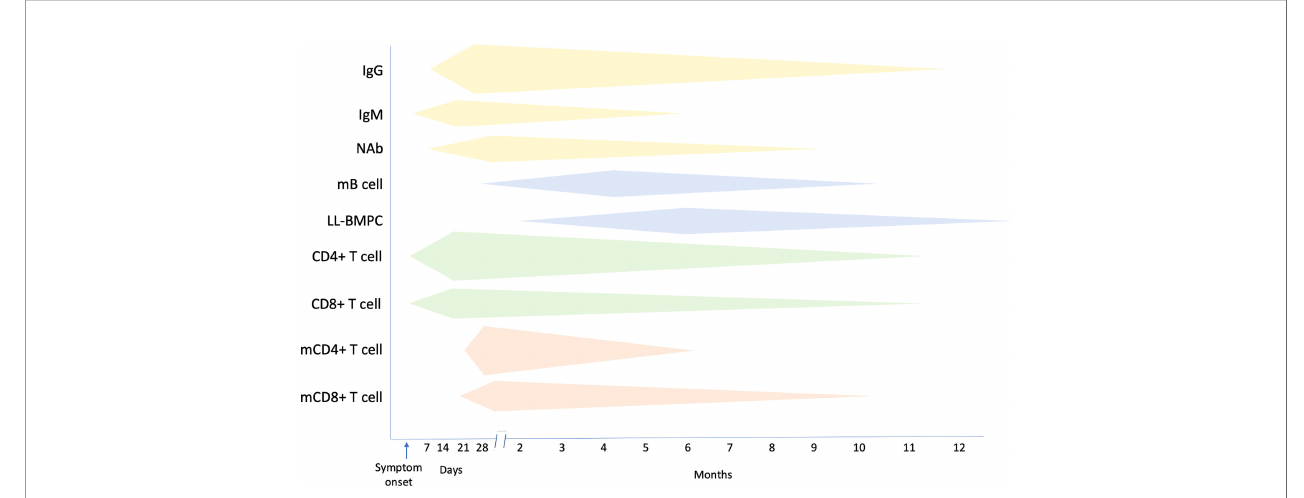
FIGURE 4 | Summary of the kinetics of immune responses following SARS-CoV-2 infection. mB cell, memory B cell; LL-BMPC, long lived bone marrow plasma cell; mCD4+ T cell, memory CD4+ T cell; mCD8+ T cell, memory CD8+ T cell. Increasing magnitude of responses is represented by a greater width of respective